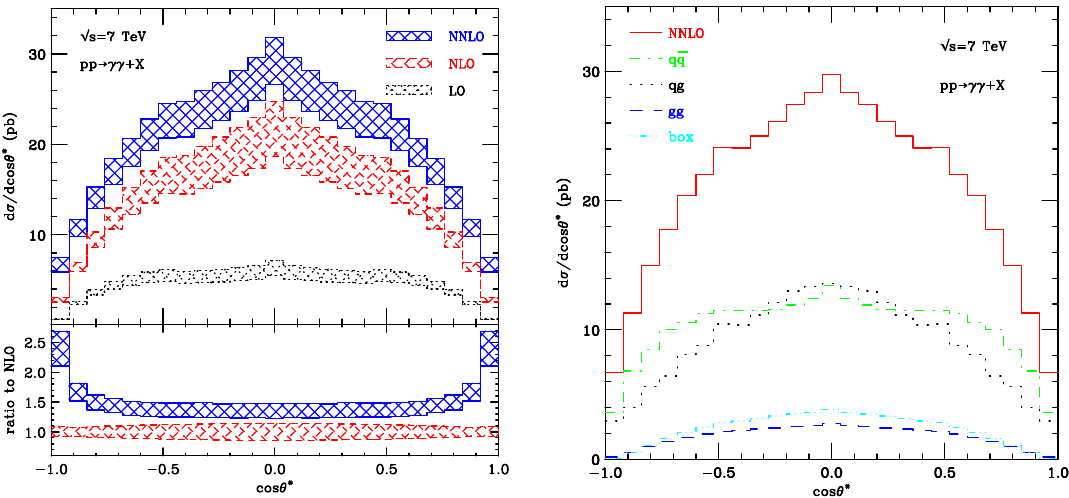
Figure 12 . The differential cross section dσ/d cos θ ∗ . The results are analogous to those in figure 11.